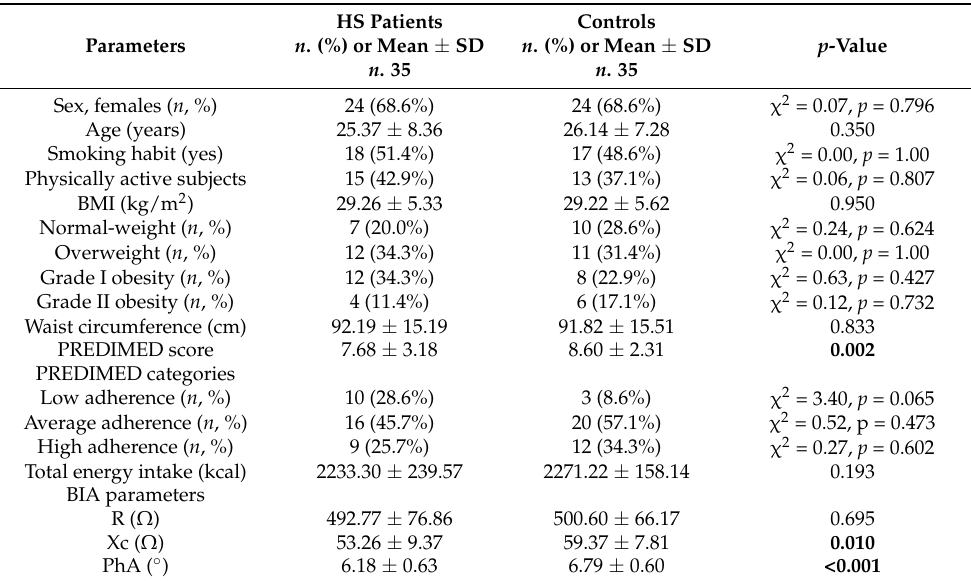
Table 1. Demographic information, anthropometric measurements, nutritional assessments, and BIA parameters of patients with HS and control